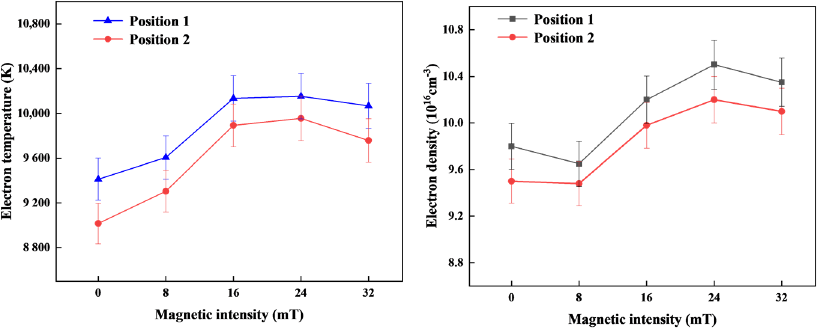
Figure 7. Effect of magnetic intensity on electron density and temperature at different positions.